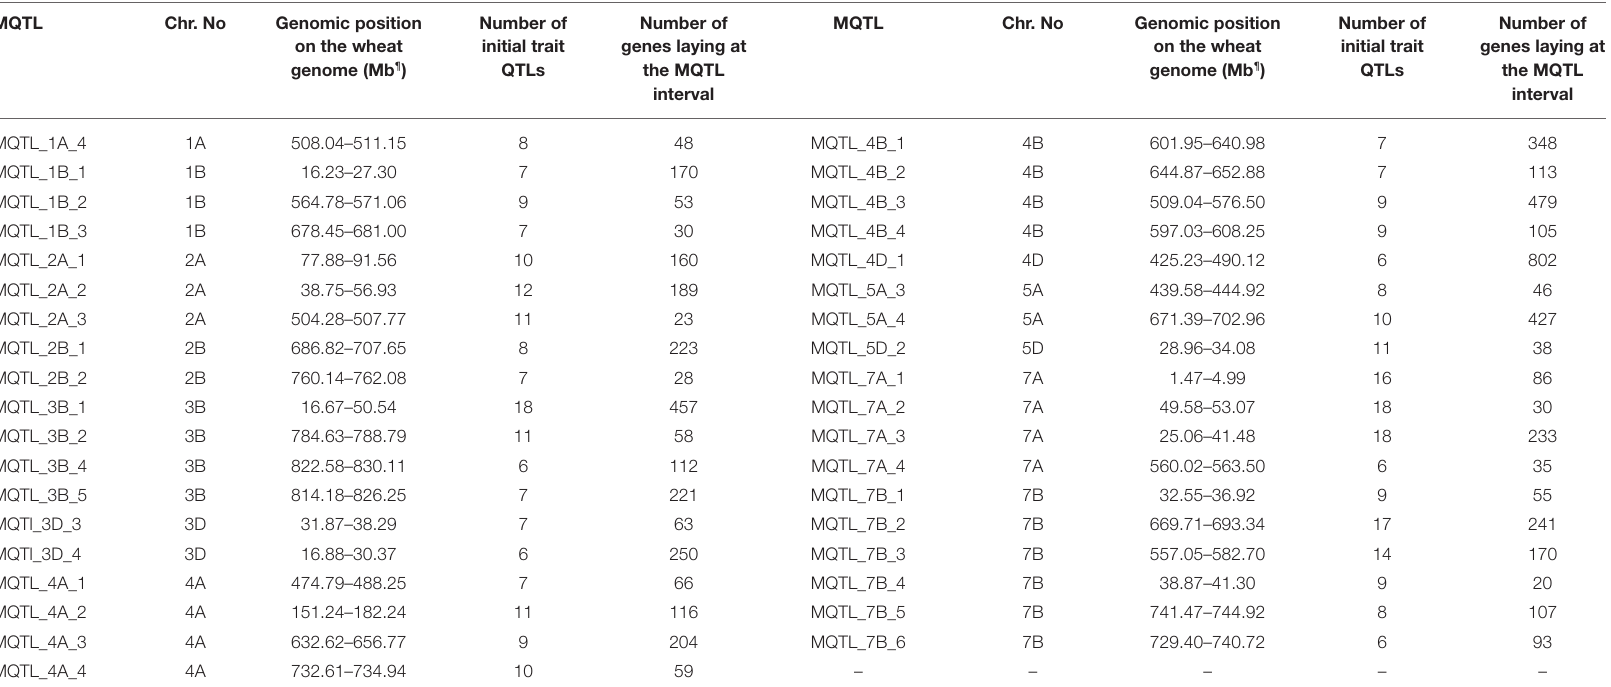
¶ Mb, represents mega base